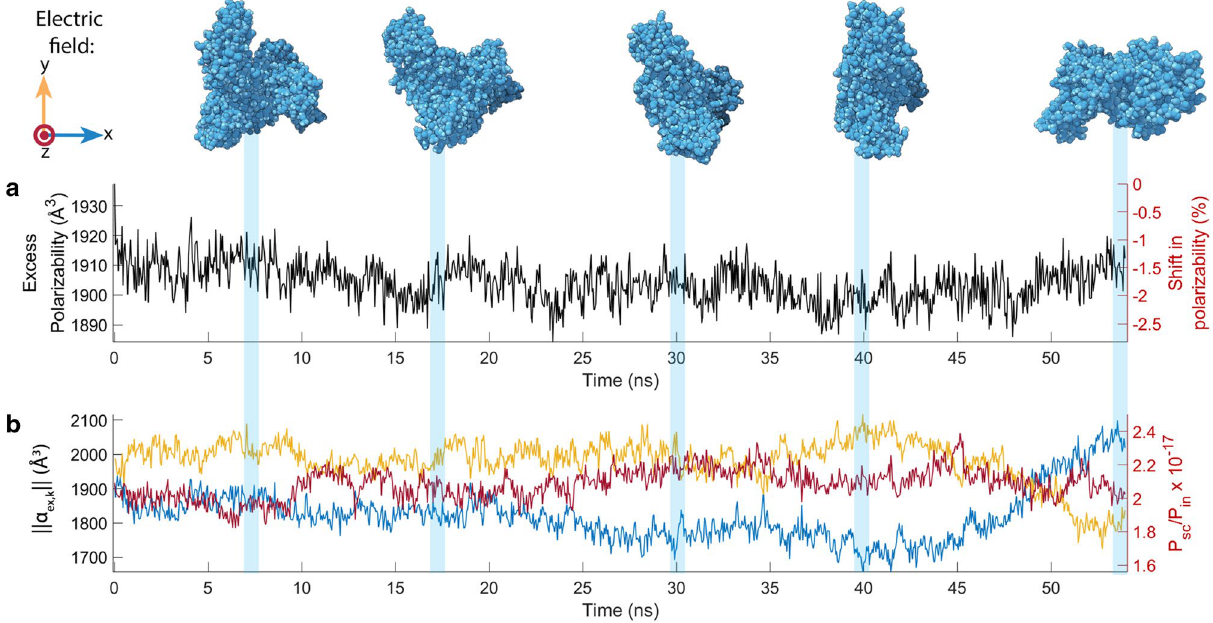
Figure 6. ( a ) Average excess polarizability fluctuations of BSA over 54 nanoseconds. ( b ) Magnitude of the polarization vector of BSA with polarized input light (in red, yellow and blue), with arrows indicating the optical electric field direction. [PDBID: 3V03] 40